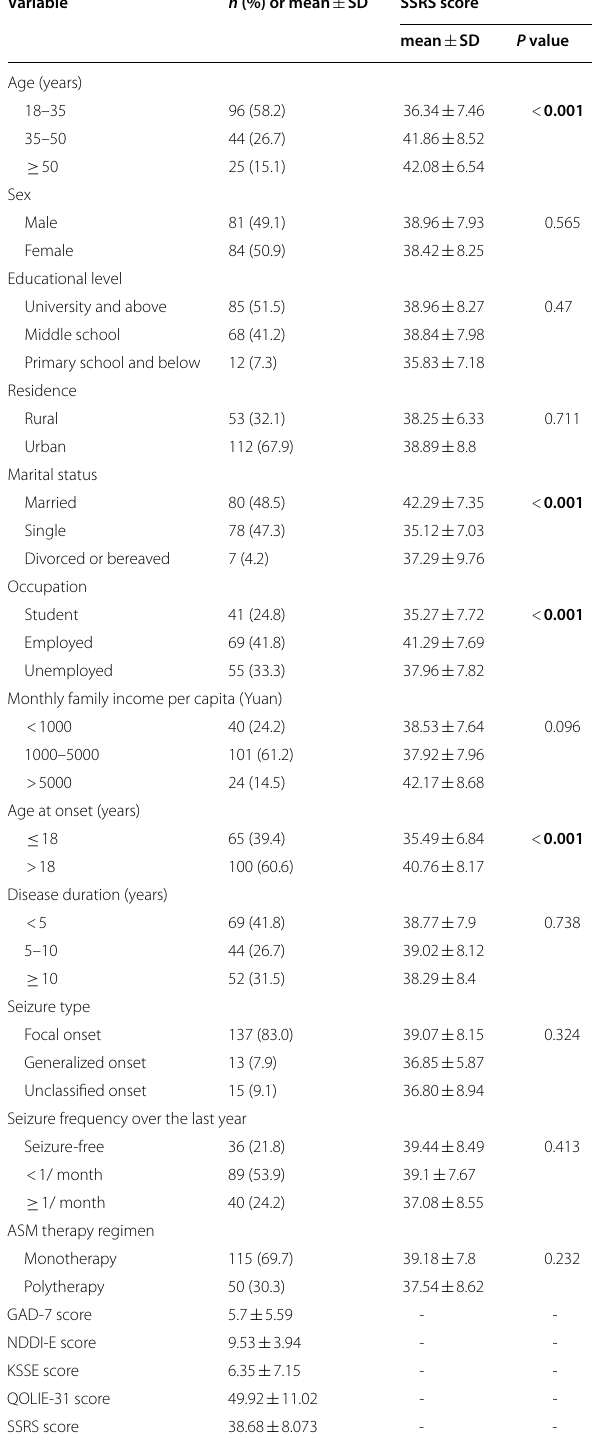
Table 1 Demographics and clinical characteristics of